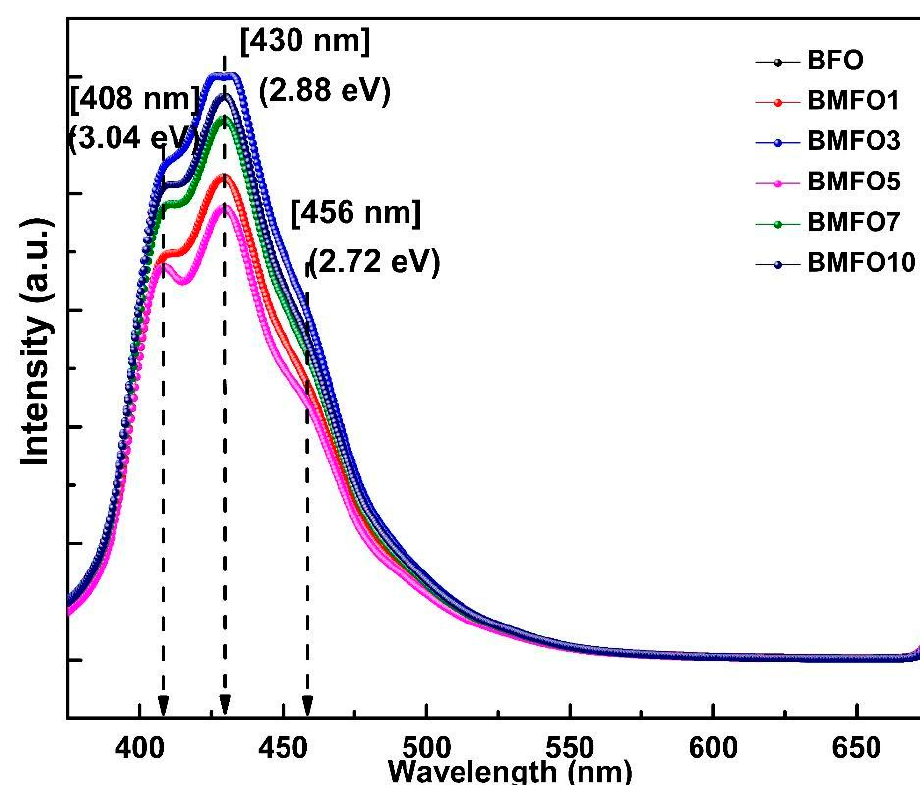
Figure 7. PL spectra of BFO, BFMO1, BFMO3, BFMO5, BFO7, and BFMO10.